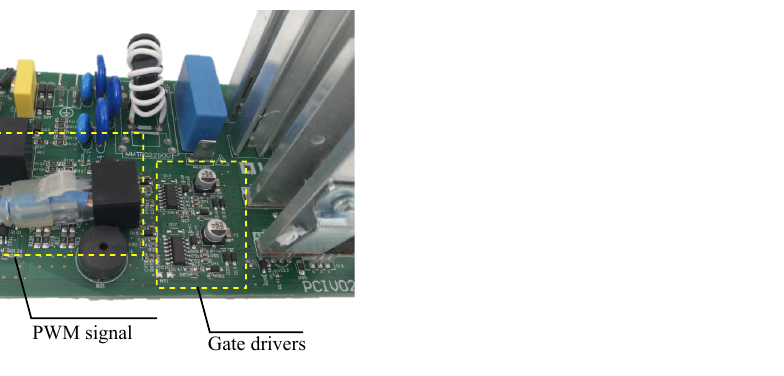
Figure 3. Connection of signals from dSpace via RJ45 to modify UPS modulation [11].